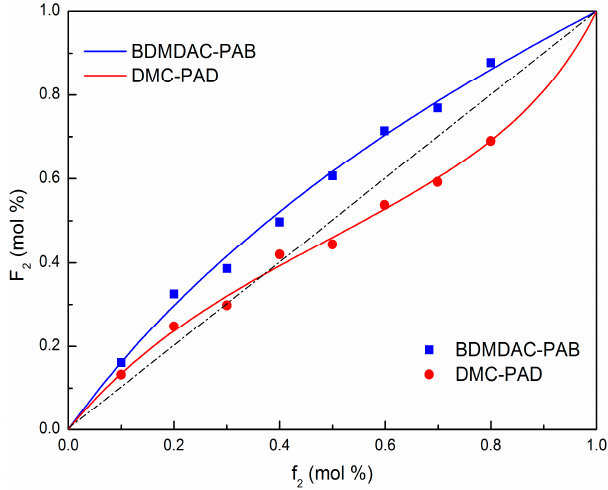
Figure 2. Composition curves and test results of the polymers. Note that the squares stand for the test results, the four solid curves are composition curves of the polymers, and the dashed line represents an ideal copolymerization.